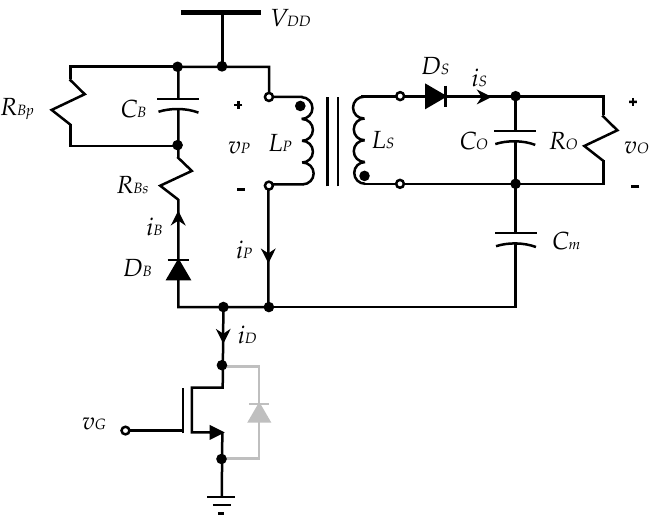
Figure 2. The equivalent circuit of flyback converter.